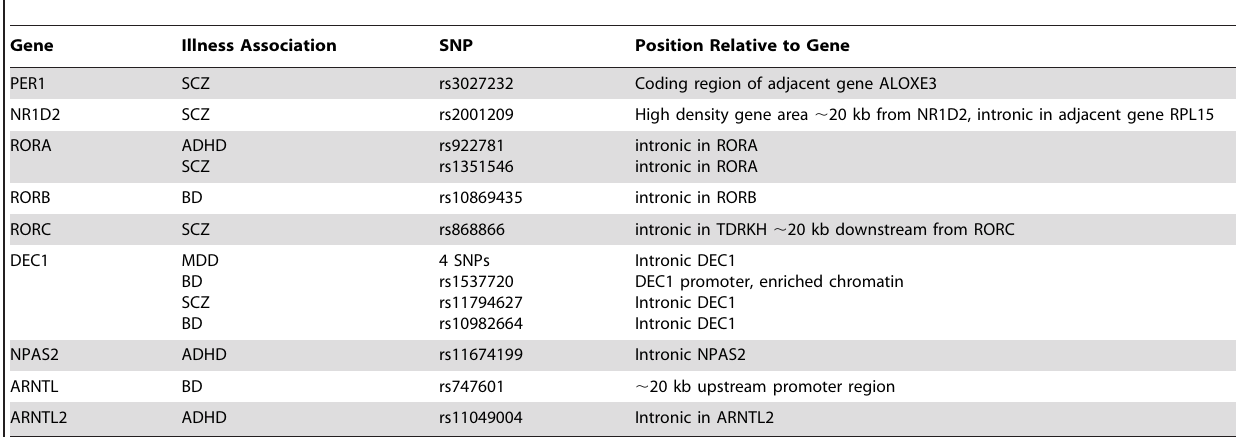
Table 2. SNPs with psychiatric illness associations and their location relative to the most proximal clock gene.